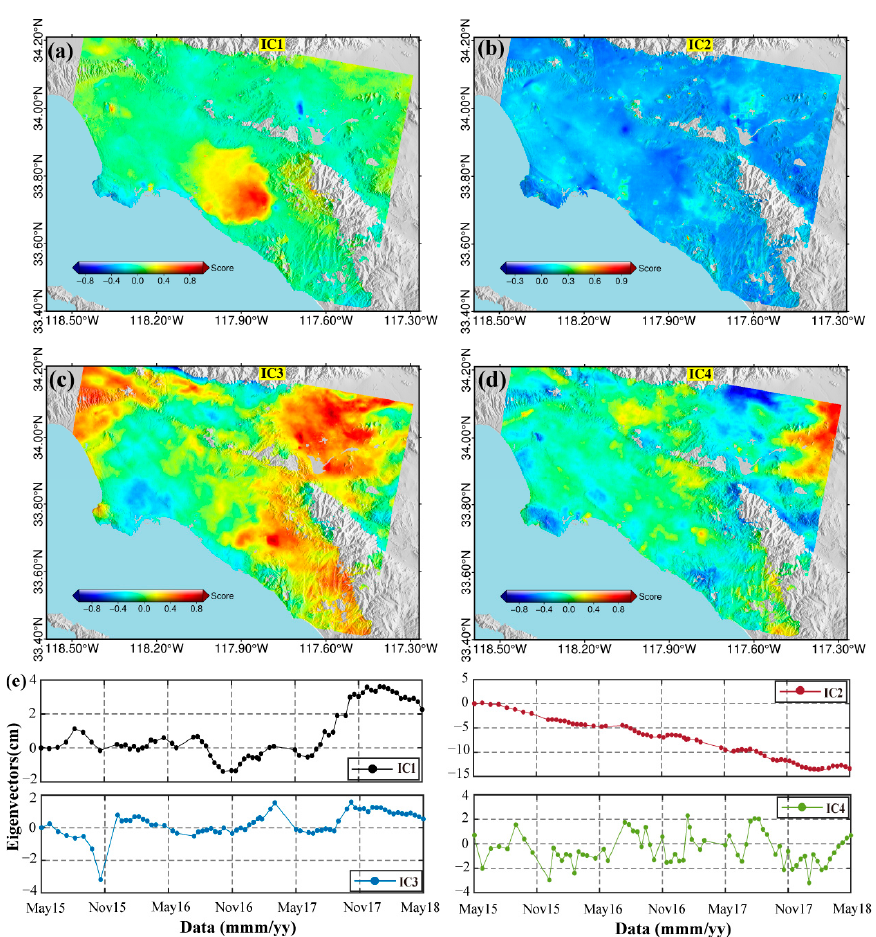
Figure 7. ICA decomposition results for the descending InSAR time series. Four independent components are isolated. ( a – d ) Score values of the spatial patterns of the four independent components, respectively; ( e ) temporal eigenvectors of each independent component.